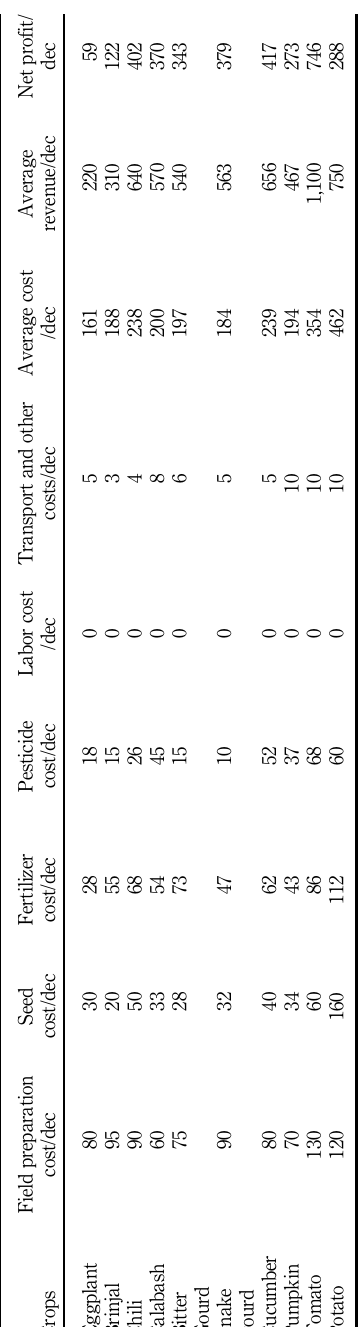
Table 7. Average cost-benefit analysis (in BDT) of some species in